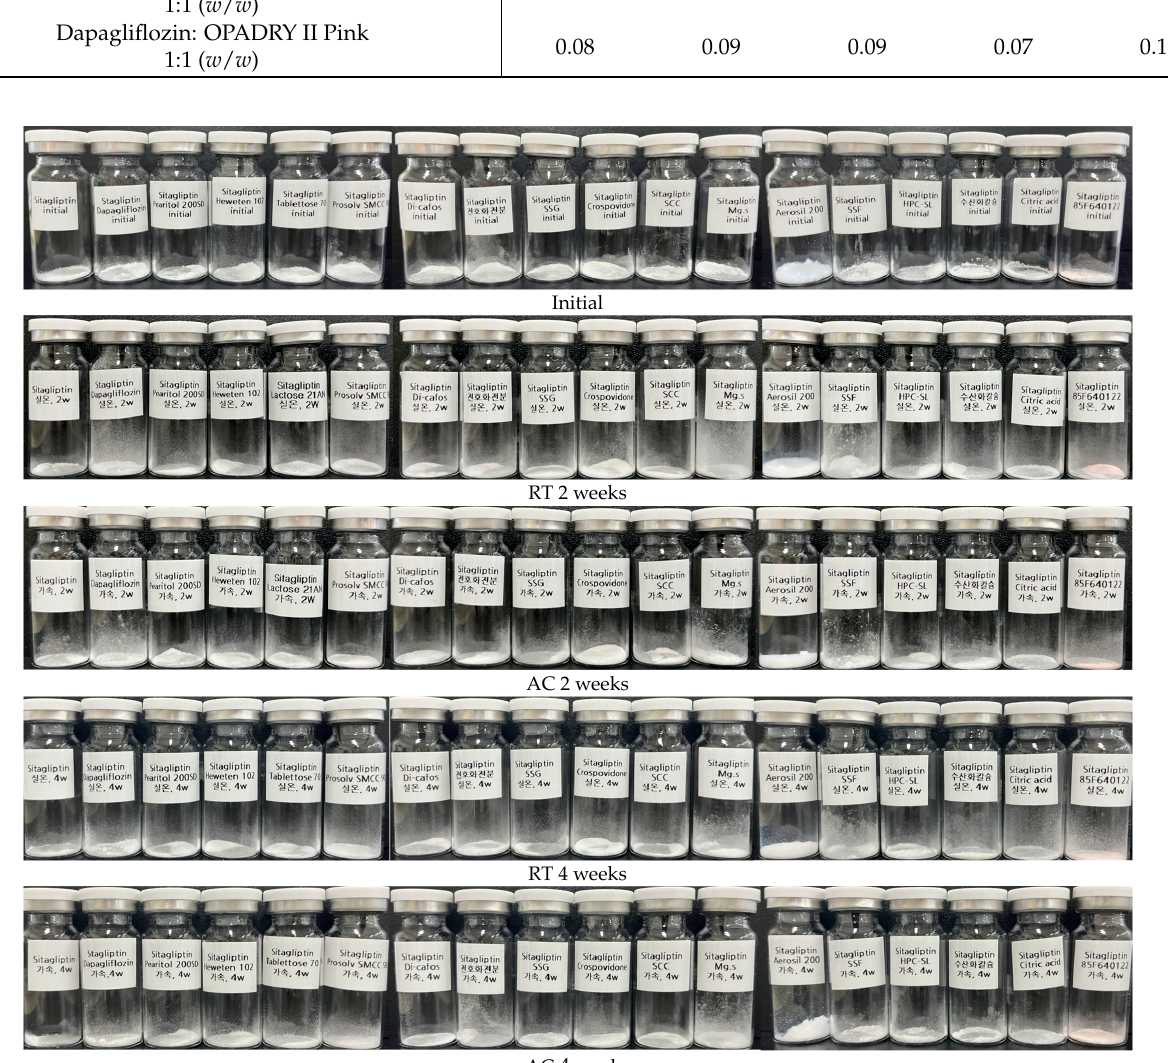
Figure 6. Appearance of compatibility test between sitagliptin phosphate monohydrate and various excipients; RT, room temperature storage condition; AC, accelerated storage condition.